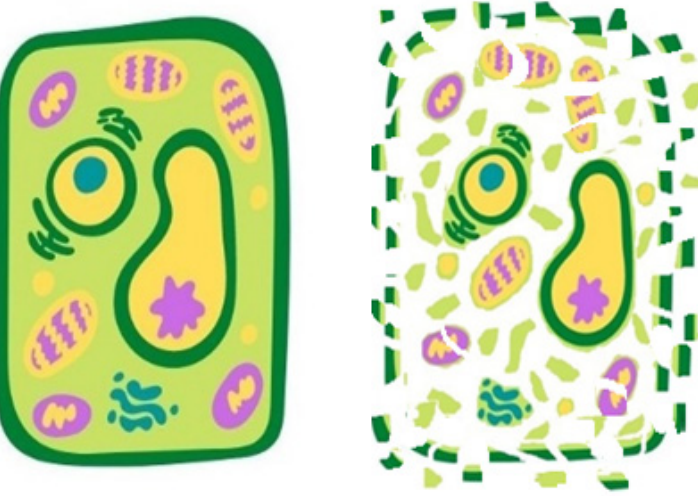
Figure 9. Mechanism of cell disintegration induced by HPH.